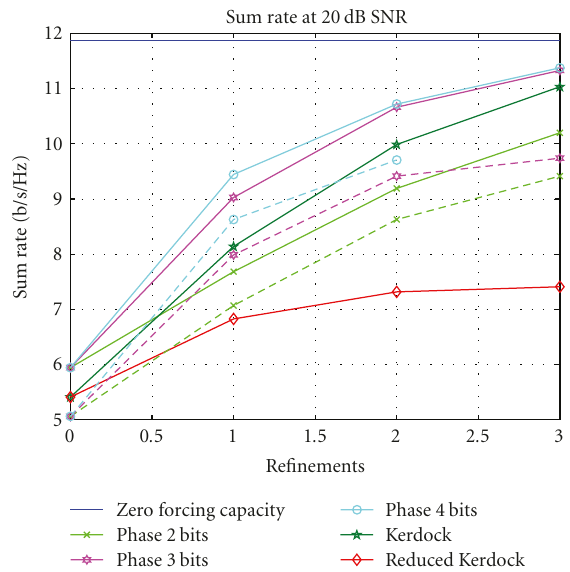
Figure 3: Sum rate performance of multiuser MIMO with N t = U = 2 at SNR = 20dB for di ff erent ring codebooks. For comparison the dashed lines correspond to sum rates achieved with random vector quantization with a total codebook size corresponding to the phase base plus refinements.